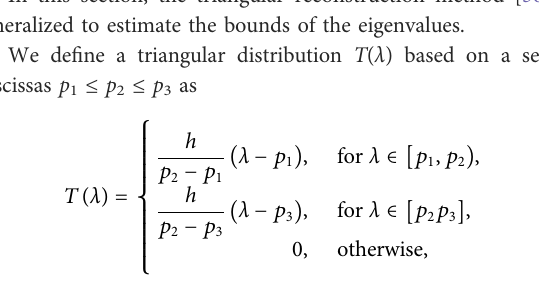
FIGURE 4 Eigenvalue histograms of C and its triangular approximations for a nearest-neighbor coupled